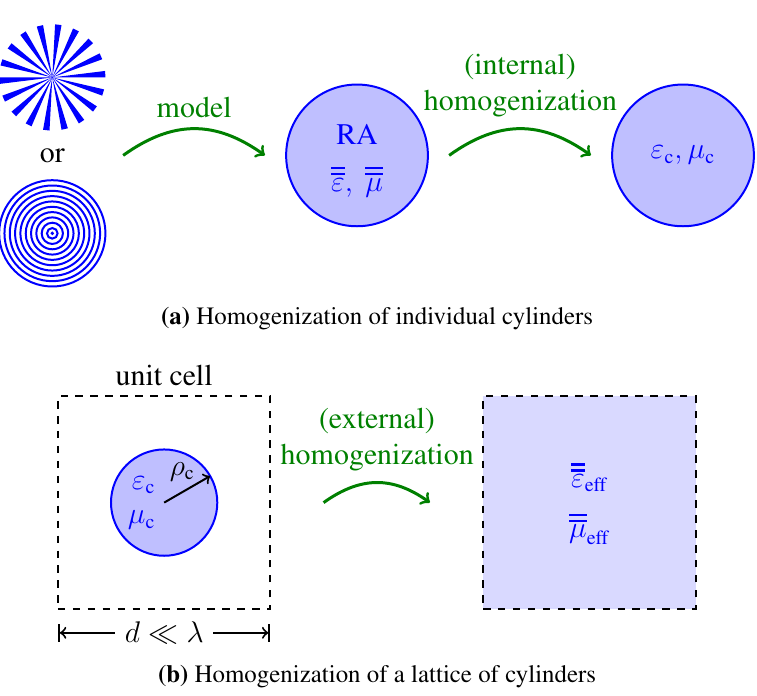
Figure 1. Schematic illustration of the homogenization procedure. RA,